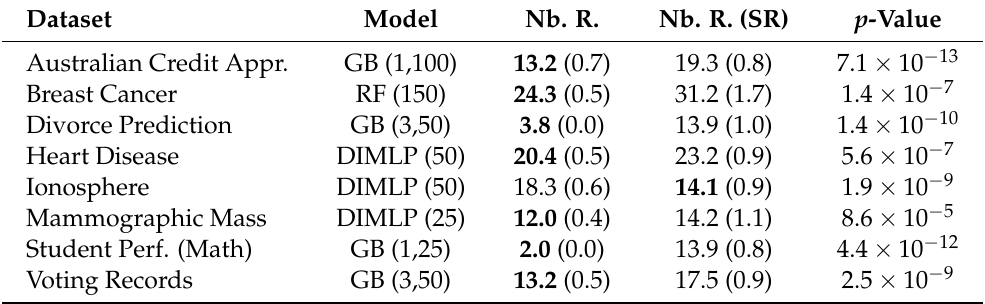
Table 11. Summary of the average number of rules extracted from the most accurate rulesets produced by DIMLPs or DTs. A comparison with SR was carried out with a Welch t -test, with p -values in the last column. A bold number represents a significantly lower number of rules.